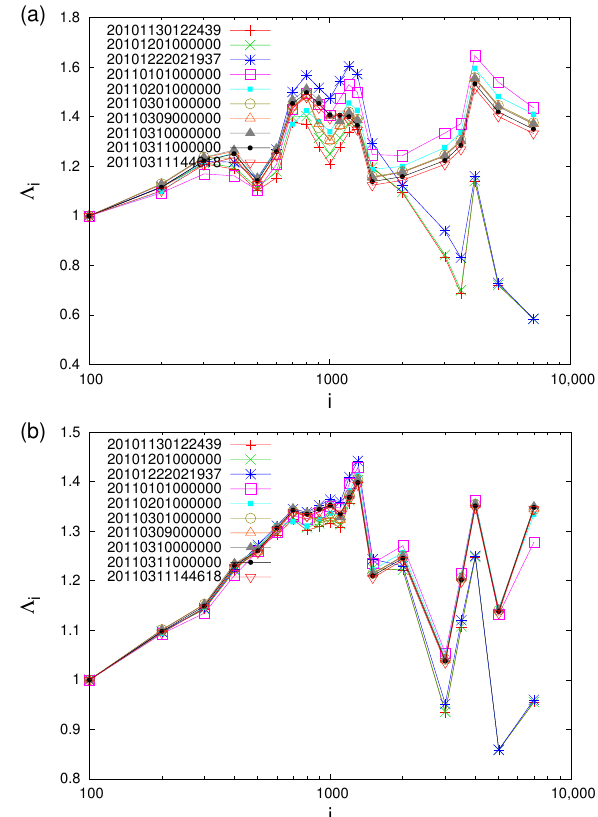
Figure 22. Plot of the Λ i values versus the scale i (number of events) for all M JMA ≥ 3.5 EQs in the entire Japanese region N 46 E 148 since 1 January 2010 ( a ) and 1 January 2006 ( b ). The values of Λ i for each scale i 25 125 are computed until the ending dates written in the text and also shown in the inset. Taken from Ref.